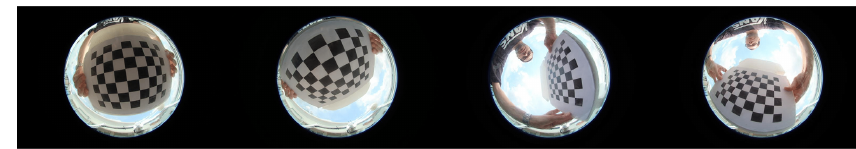
Figure 2. We position the checkerboard at various locations for geometric camera calibration.